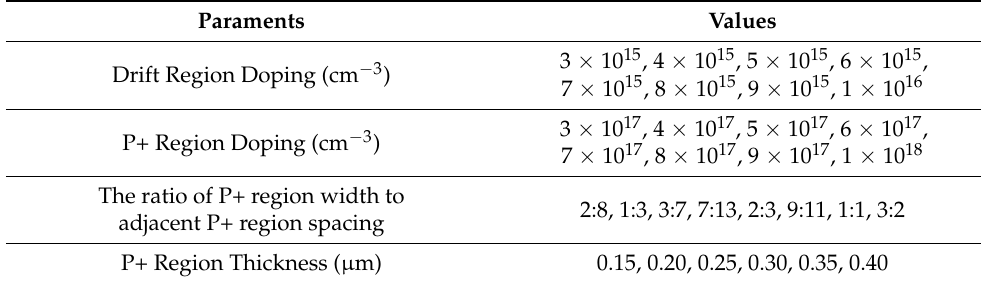
Table 2. The control group of each sensitive parameter in the sample